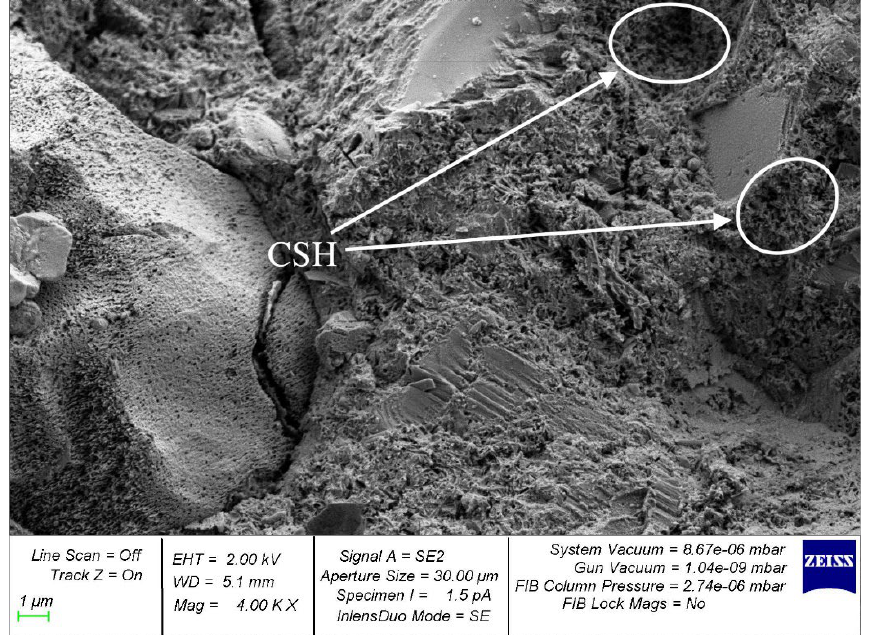
Figure 17. SEM image of the structure of an electromagnetically treated hardened cement paste with 10% RSA in place of part of the cement.